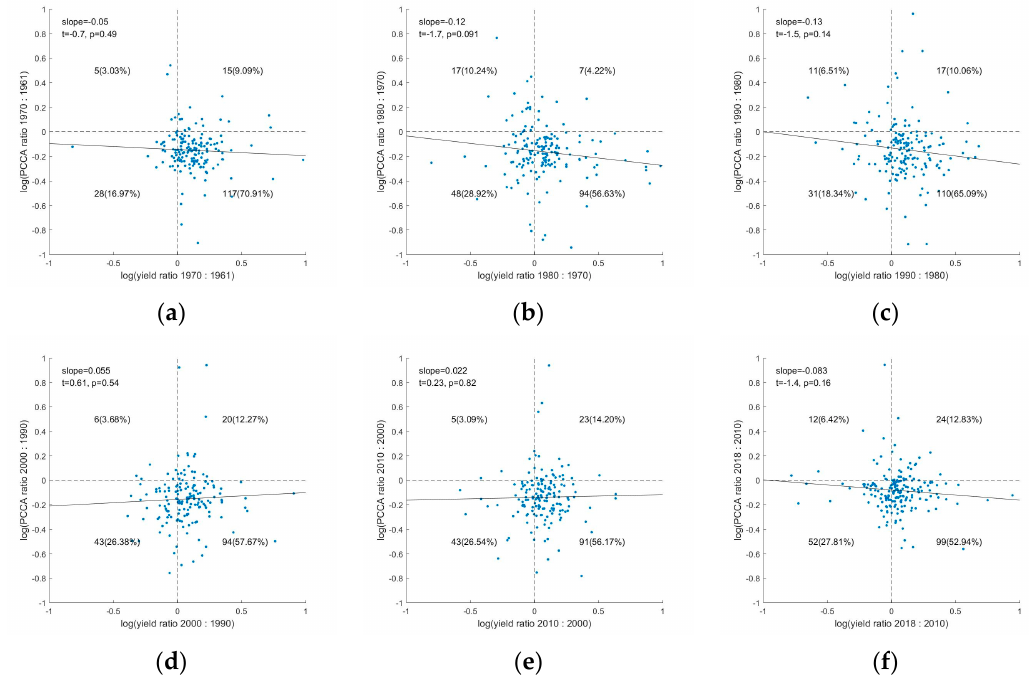
Figure 6. For nonclassified countries, the relationship between the PCCA change and the yield change at the country scale during different time periods: ( a ) 1961–1970; ( b ) 1970–1980; ( c ) 1980–1990; ( d ) 1990–2000; ( e ) 2000–2010; and ( f ) 2010–2018. Solid lines are best-fit lines of least squares linear regression models. Graphs are divided into four quadrants by dashed